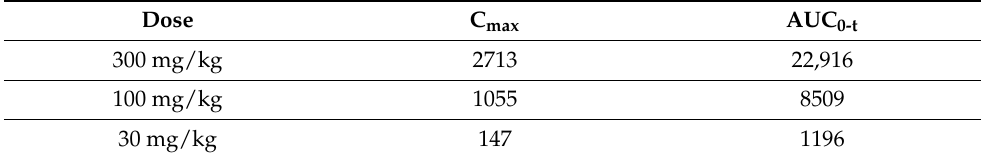
Figure 5. Treatment of SCID-hu Thy/Liv mice with NBD-14189 was well tolerated with no change in body weight ( A ), no apparent deleterious effects on Thy/Liv implant cellularity ( B ) or CD4 + CD8 + thymocytes ( C ), and high C max NBD-14189 plasma concentrations ( D ). The columns represent the means, and the open circles represent individual mice from the same mouse cohort. Values for treated groups were not statistically significant ( p > 0.05) from untreated mice by the Mann-Whitney U test. Table 5. Pharmacokinetics parameters of NBD-14189 in SCID-hu Thy/Liv mice.